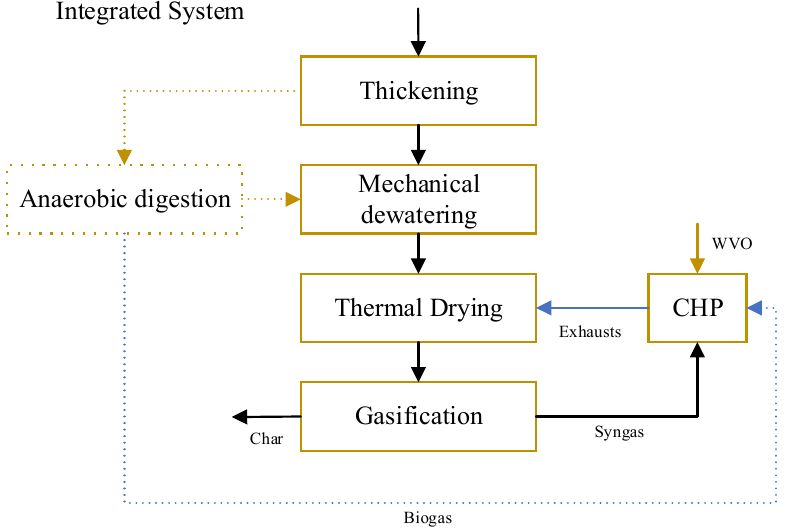
Figure 10. Block diagram of a bioenergy system in WWTP facility (WVO = waste vegetable oil).